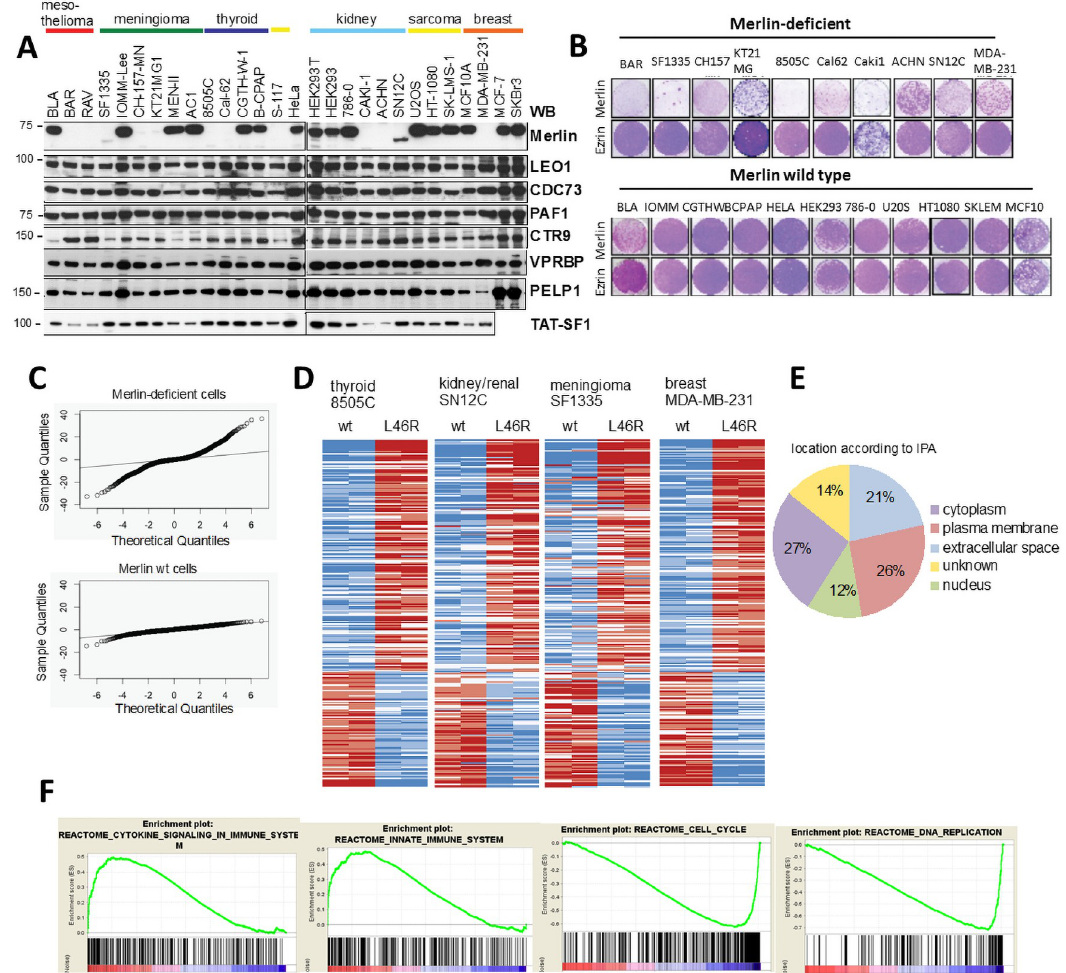
Fig 5. Growth arrest by Merlin is associated with a cross-tissue gene expression program. (A) Merlin protein expression (but not identified interactors) is lost in several tumour cell lines. (B) Merlin-deficient cell lines are hypersensitive to ectopic expression of Merlin. Cells were infected with retroviruses expressing either Ezrin or Merlin and stained with crystal violet 6–12 days later. (C) Merlin expression is associated with far more gene expression changes in Merlin-deficient compared to wild type cells as evidenced by a far greater dispersion of limma t-values compared to the theoretical null distribution (indicated by the black line). (D) Heatmap representing significantly regulated genes in response to expression of wild type Merlin compared to Merlin L46R across four Merlin-deficient cell lines. Blue and red denote low and high expression respectively. (E) Merlin re-expression/hypersensitivity gene signature is enriched in proteins that locate to the plasma membrane and extracellular space. Protein location based on the Ingenuity pathway analysis software IPA (Qiagen). (F) Selected biological pathways from Reactome database regulated by Merlin identified by GSEA. Two representative enrichment plots are shown for up- and down-regulated pathways. See also S4